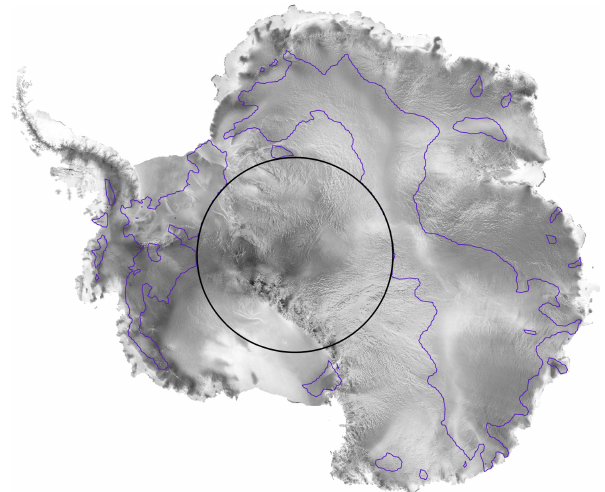
Figure 9. Distribution of the date of maximum backscattering co- efficient at the Ku band superimposed on the RADARSAT mosaic (RAMP). Blue contour lines show the boundaries between the WP and the SP over the Antarctica Ice Sheet. SPs are regions where the backscattering coefficient reaches a maximum in summer (inset of the contours), and WPs are regions where the backscattering coef- ficient reaches a maximum in winter (where snow surface features are apparent). No observations are available beyond 81.5 ◦ S (black